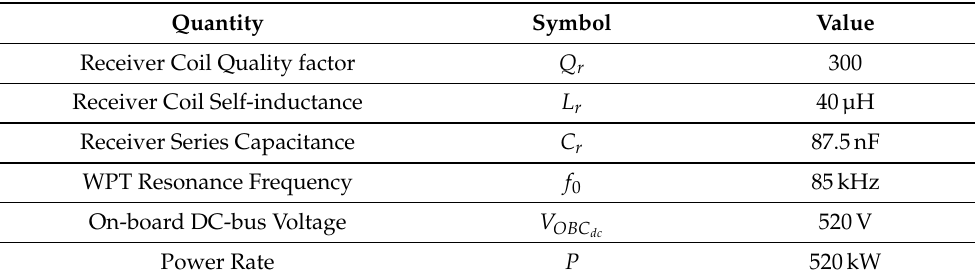
Table 2. Receiver